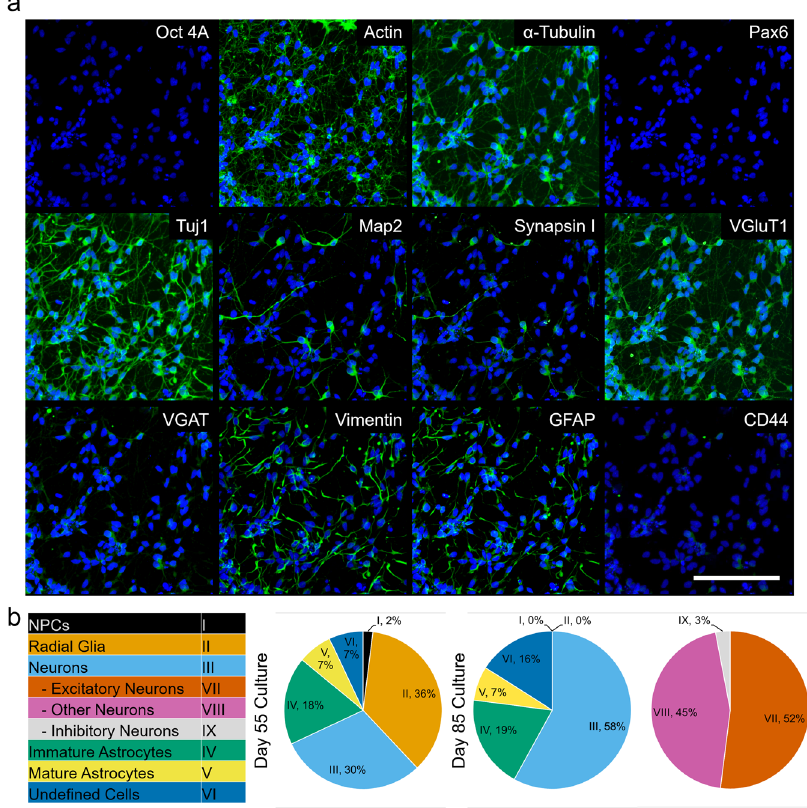
Fig. 3 High-content analysis of dissociated cultures from hiPSC-derived cortical neurons. a Representative images from the same area of a 85 days old BJ-SiPs-derived cortical neuron culture, stained with the optimized 12-marker PRISM antibody panel, 14 days post-dissociation into 2D cultures.